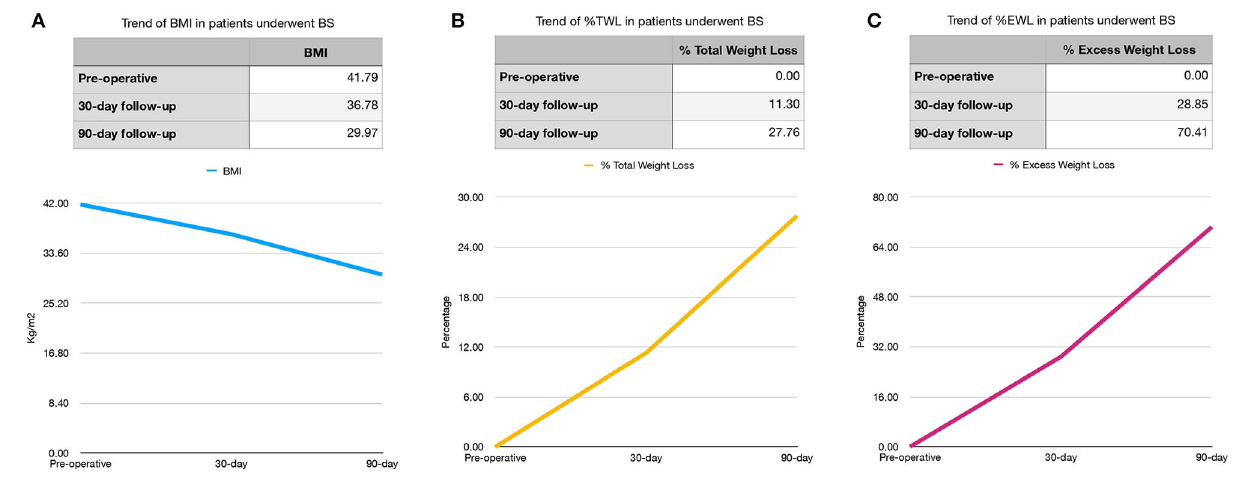
FIGURE 1 | Preoperative, 30- and 90-day BMI (A) and %TWL (B) and %EWL (C) trends in bariatric surgery (BS) patients. BMI, body mass index (kg/m 2 ); %TWL, Total Weight Less; %EWL, Excess Weight